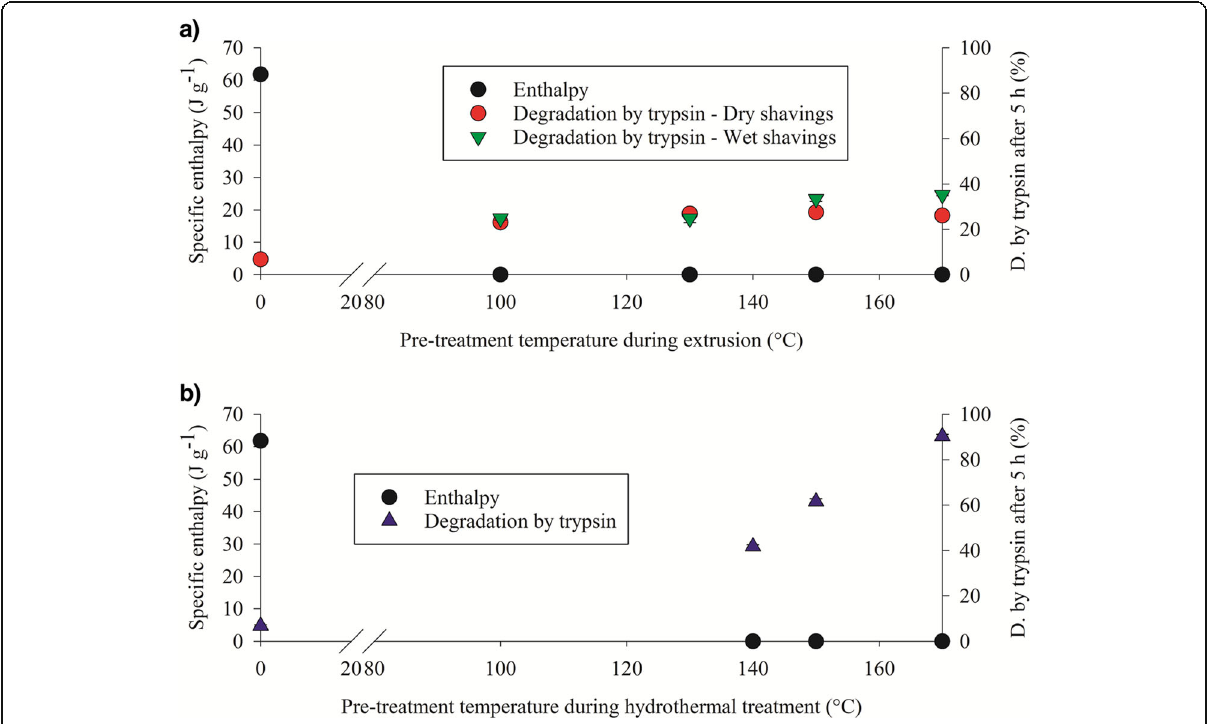
Fig. 2 Enthalpy of denaturation and degradation by trypsin of extruded shavings ( a ), shavings treated hydrothermally ( b ), and CS